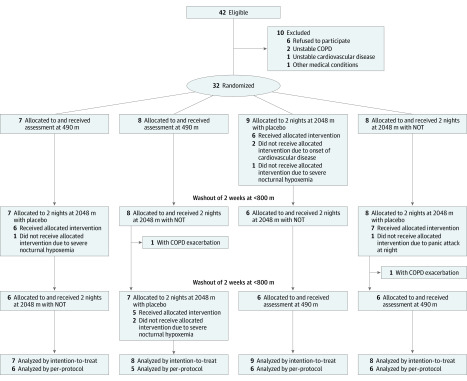
Study Flow DiagramAltitude allocation sequence and order of intervention (oxygen or placebo) at 2048 m were randomized. After evaluations at 2048 m, a 2-week washout period below 800 m was applied to avoid carry-over effects. COPD indicates chronic obstructive pulmonary disease.